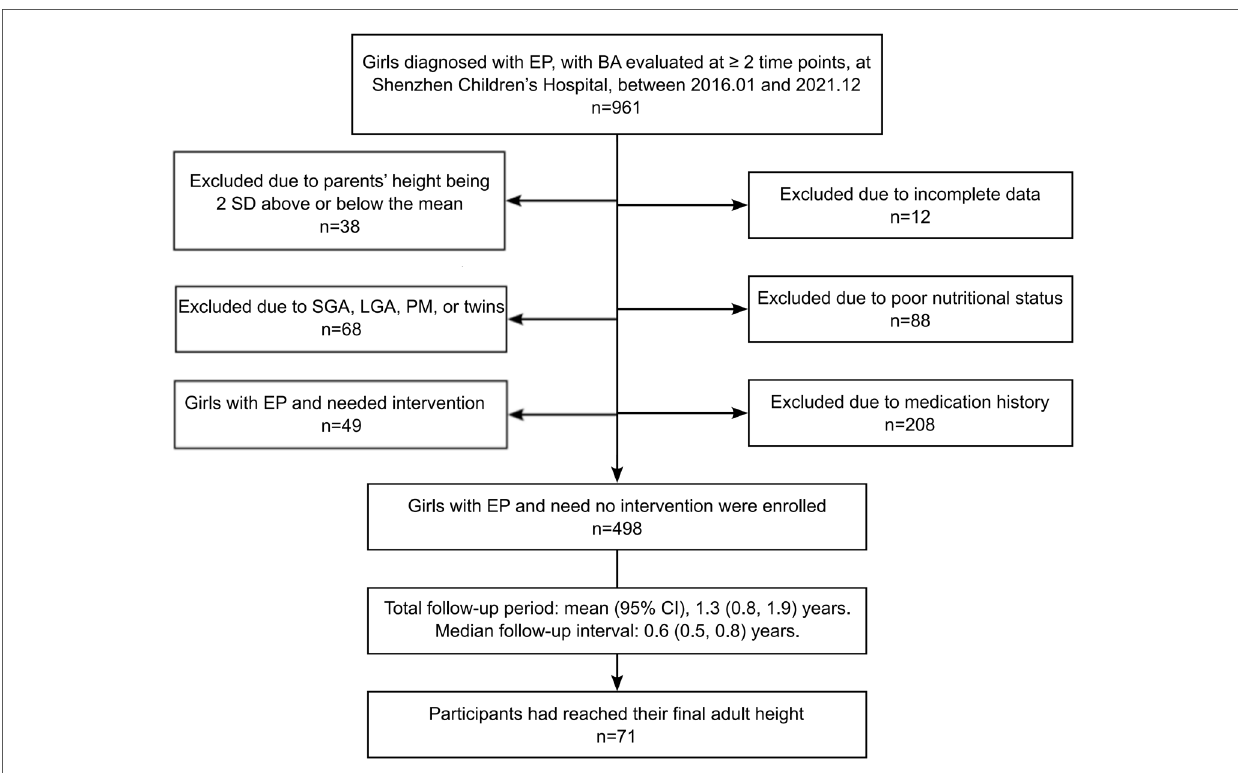
FIGURE 1 Flow chart for the selection of participants. EP, early-onset puberty; BA, bone age; SGA, small for gestational age; LGA, large for gestational age; PM, premature